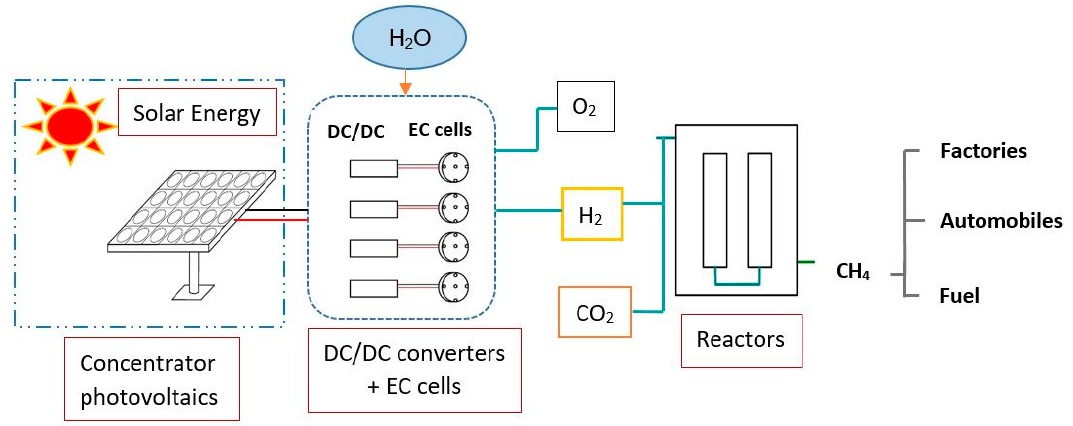
Figure 1. Schematic illustration of the fundamental solar to methane (StM) concept of our system.